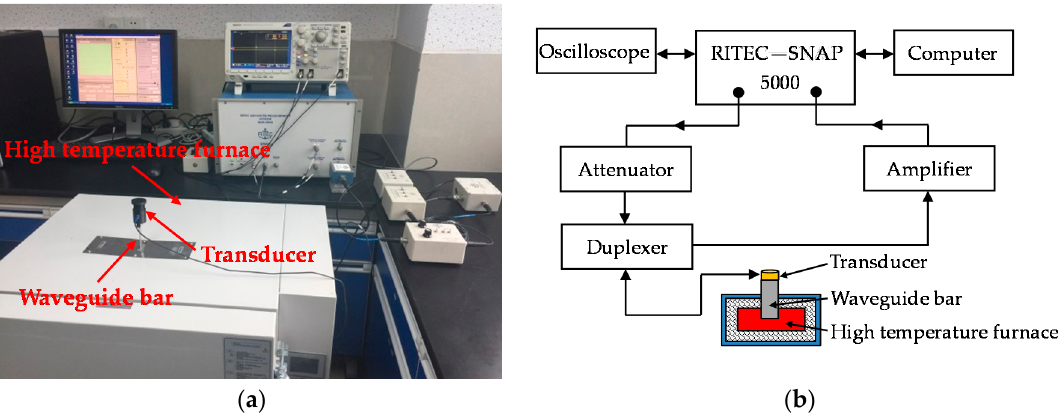
Figure 15. High temperature e xperimental system: ( a ) Experimental set-up; ( b ) System sketch map.